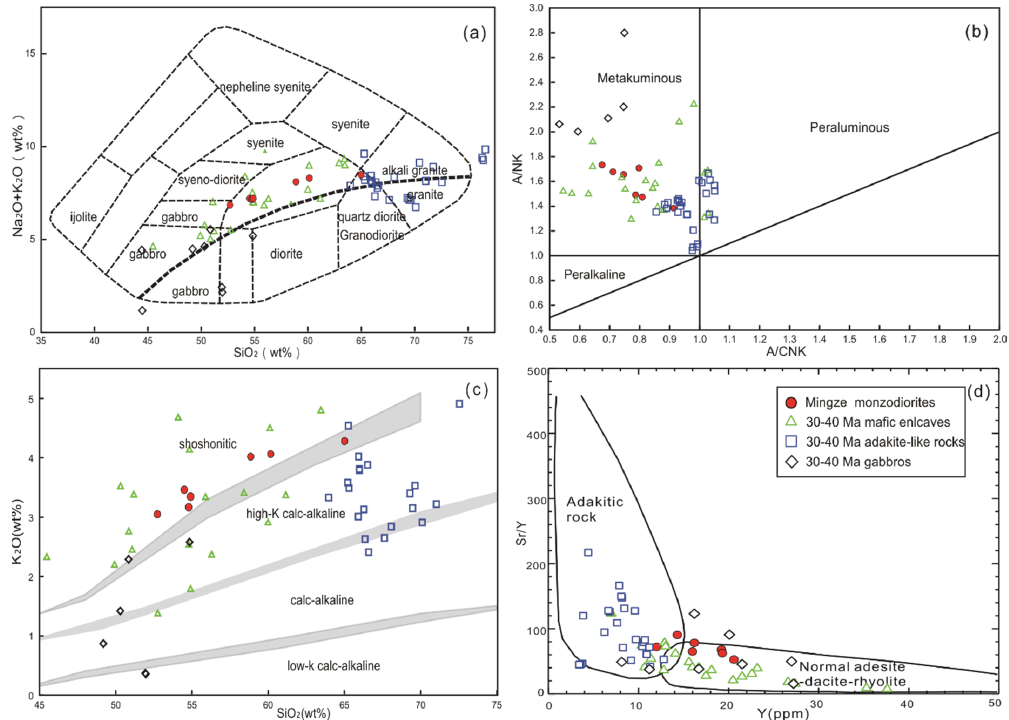
Figure 4. Variation diagrams for representative major and trace elements. ( a ) Total alkalis versus silica (TAS) diagram; ( b ) SiO 2 vs. K 2 O diagram; ( c ) K 2 O–SiO 2 diagram; ( d ) Sr / Y–Y classification diagrams.